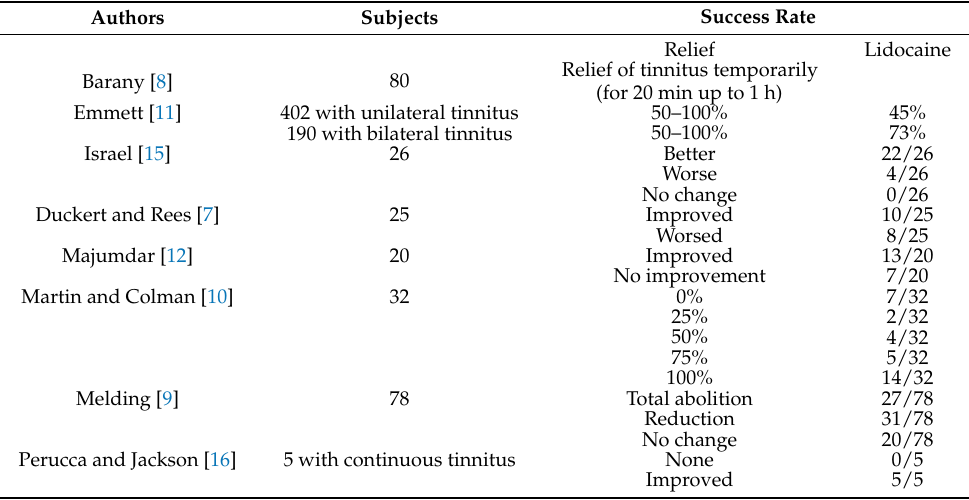
Table 2. Summary of studies that used lidocaine to treat